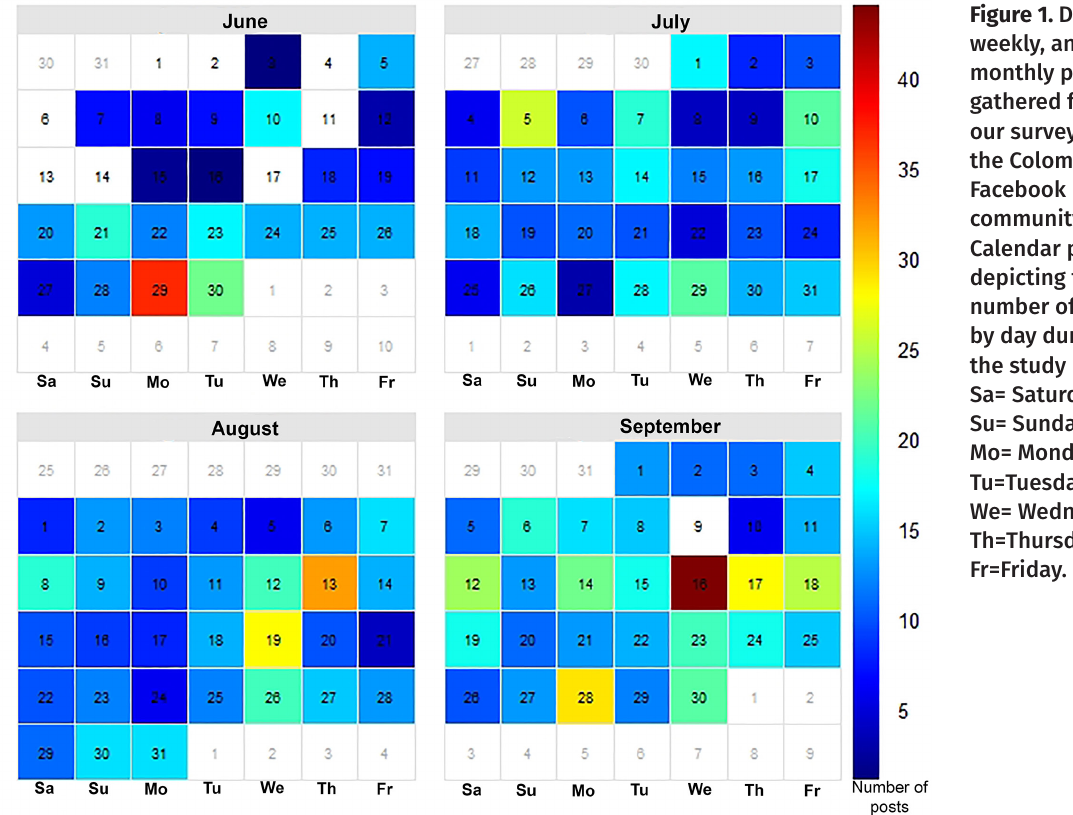
Figure 1. Daily, weekly, and monthly posts gathered from our survey of the Colombian Facebook community. Calendar plot depicting the number of